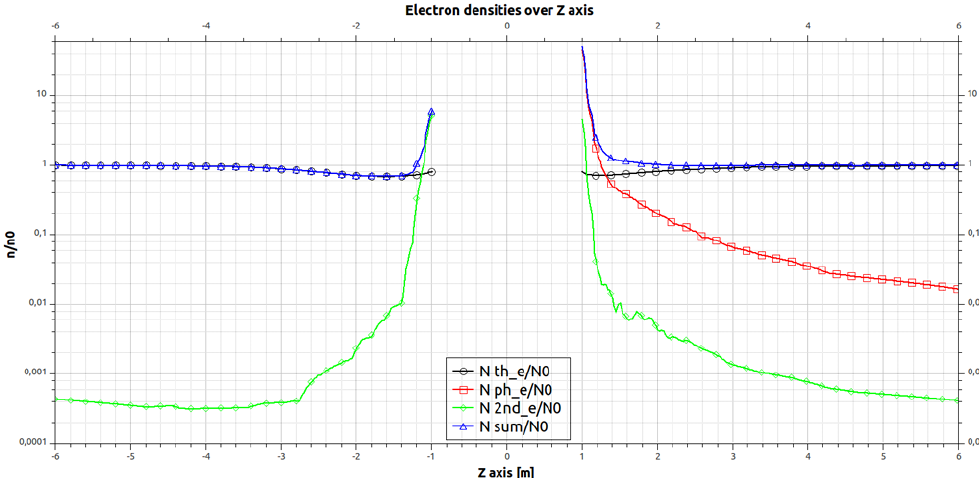
Fig. 15. Simulation S2: plot along the z-axis of electrons over n 0 , the plasma density: 7 × 10 9 m − 3 .